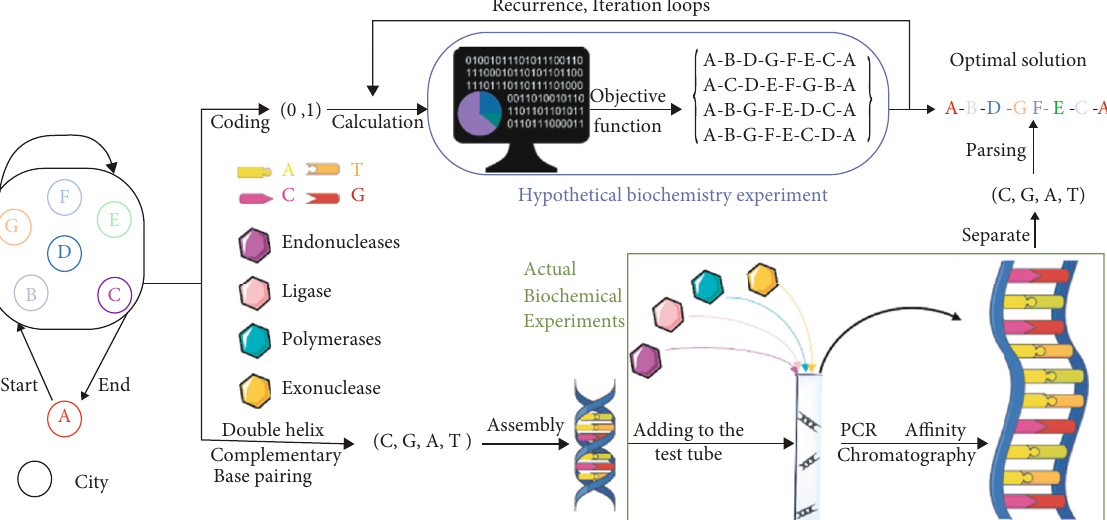
Figure 1: The shortest route from city A through B, C, D, E, F, G, and then back to city A is calculated by DNA algorithm and genetic algorithm.